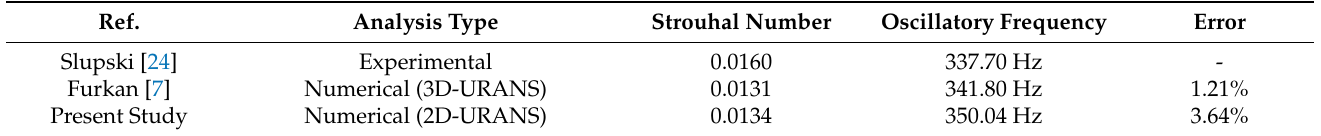
Table 2. Model validation and verification.